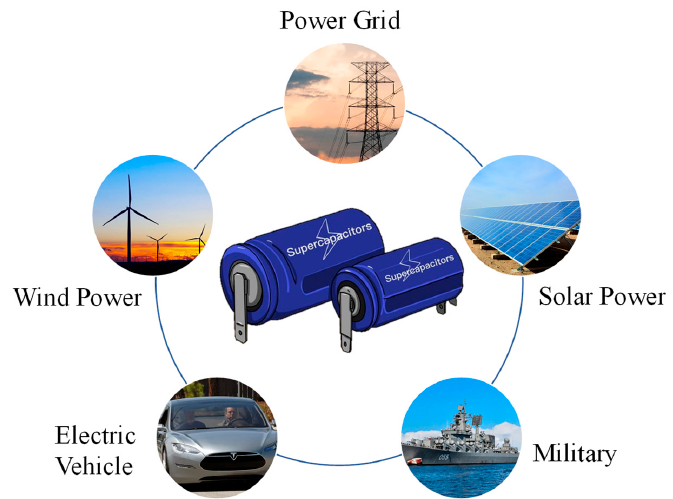
Figure 2. Application domain of supercapacitors.